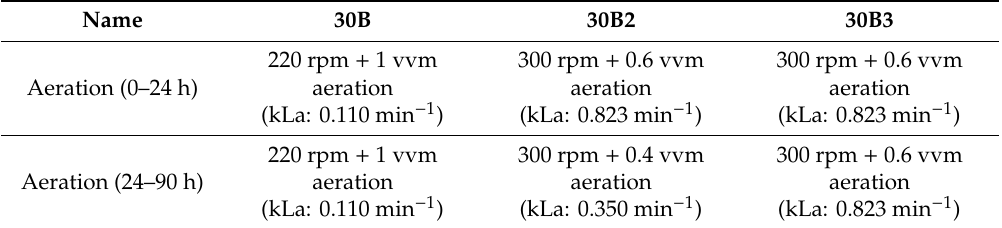
Table 4. Aeration conditions and corresponding oxygen mass transfer coe ffi cients used in 30B, 30B2 and 30B3.